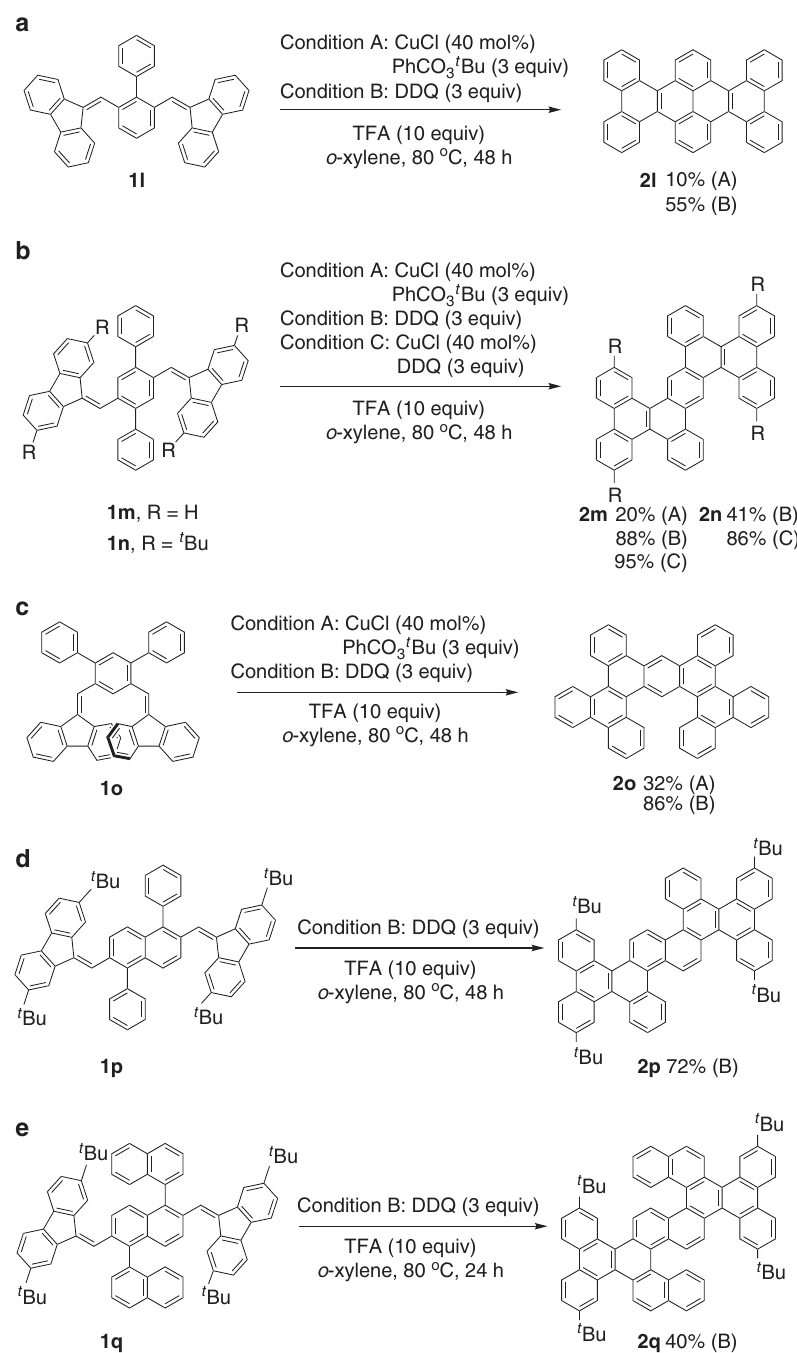
Figure 3 | Synthesis of extended PAHs. Double annulations of ( a ) biphenyl-centered bis-methylenefluorenes, ( b ) p -terphenyl-centered bis-methylenefluorenes, ( c ) m -terphenyl-centered bis-methylenefluorenes, ( d ) 1,5-diphenylnaphthalene-centered bis-methylenefluorenes